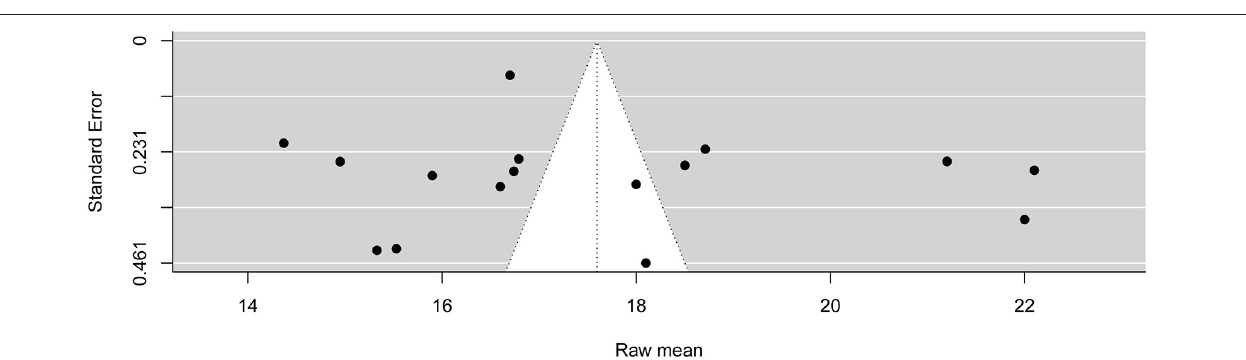
FIGURE 5 | Funnel plot of publication bias based on Egger’s regression